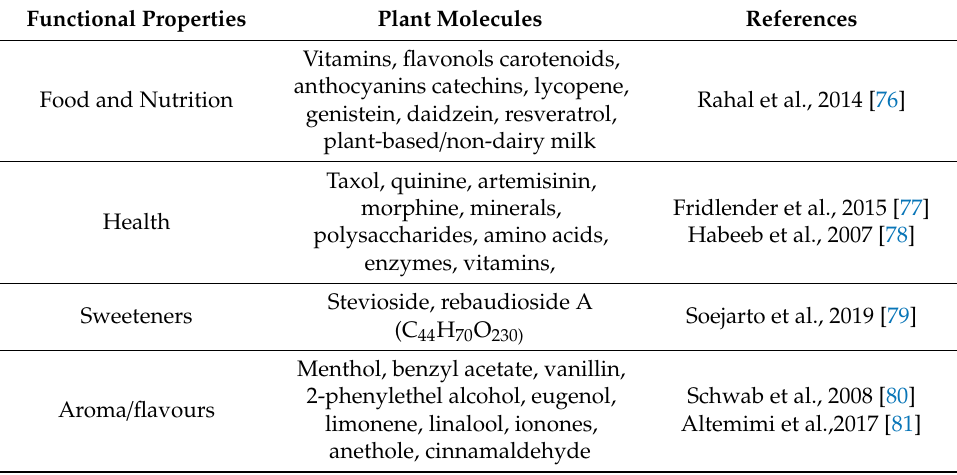
Table 3. Examples of herbal molecules used in the industry of health and food. Functional